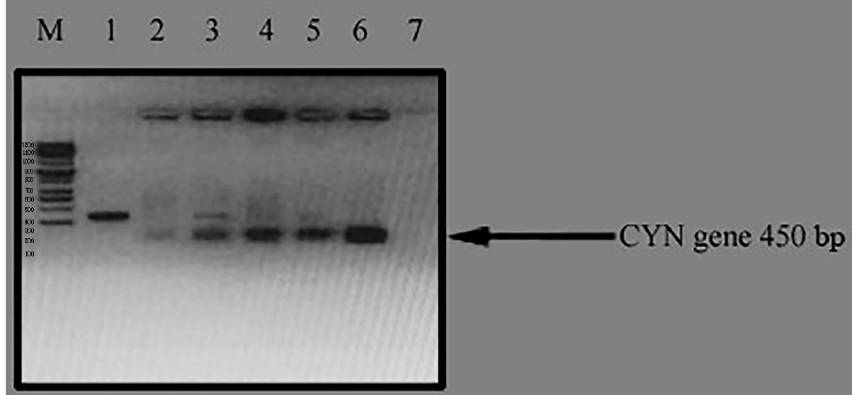
Figure 4. Colony PCR test for positive clones of Agrobacterium tumefaciens for pTRA ‐ K ‐ CYN. M: 100 bps DNA ladder; Lane 2, 3, 4, 5, 6: positive clones of A. tumefaciens ; Lane 1,7: negative clones of A. tumefaciens.